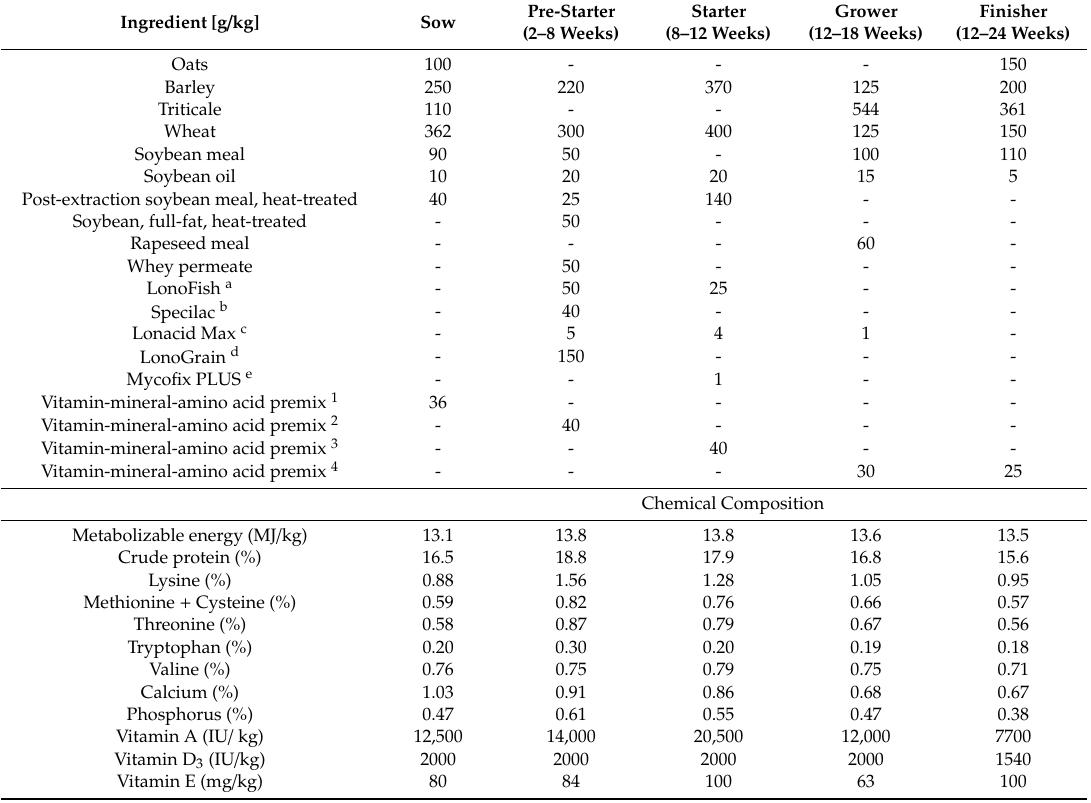
Table 2. Feed components and chemical composition